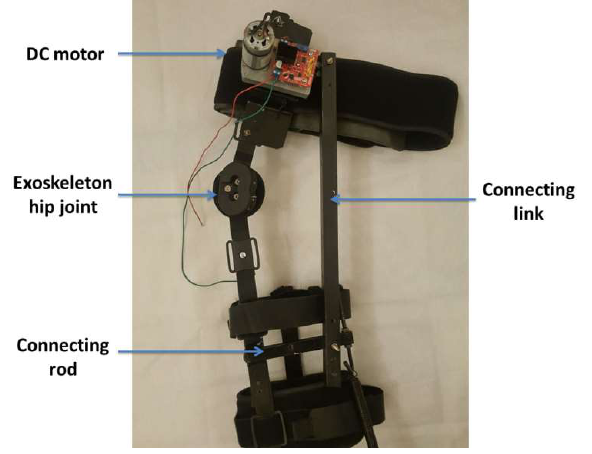
Fig. 8. Exoskeleton hip joint mechanism.